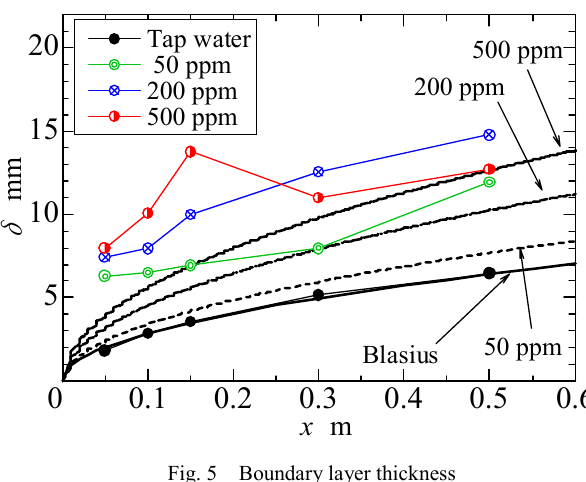
Fig. 5 Boundary layer thickness